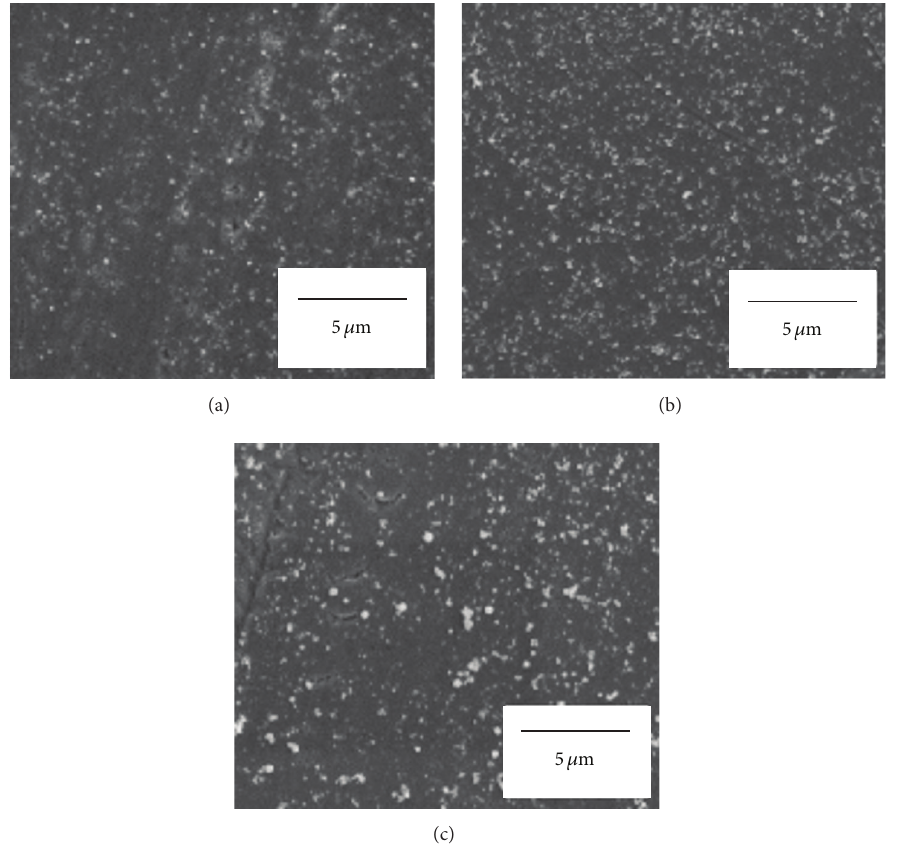
Figure 2: Surface SEM images of the films deposited at various Y 2 O 3 concentrations in a suspension solution (0.5, 2.0, and 5.0 wt%), with bias voltage of 0.5 V and bias frequency of